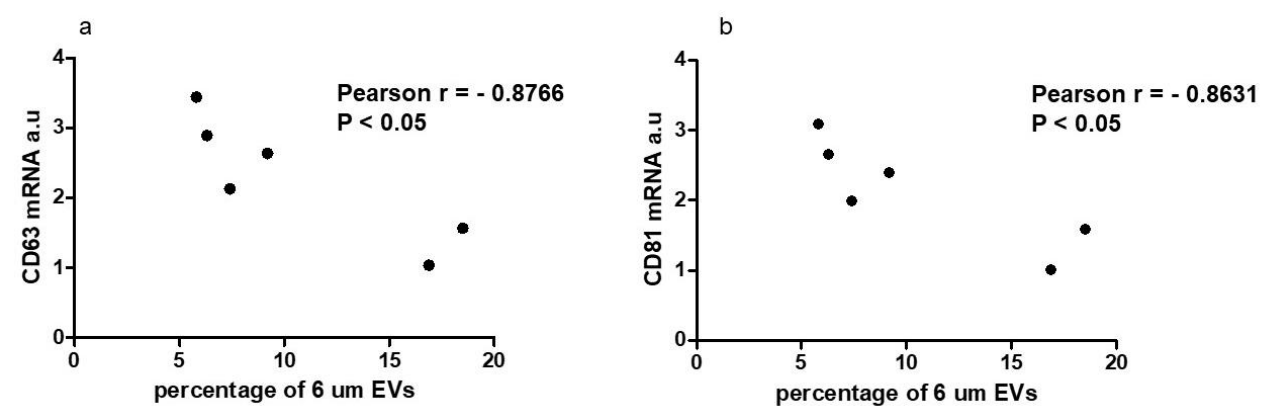
Figure 6. The number of cancer-derived 6 µ m EVs correlates with the expression of tetraspanins. The plots show the Pearson correlation between the expression levels of CD63 ( a ); and CD81 ( b ) in NTHY cells (after incubation with cancer-derived EVs) and the percentage of 6-µm extracellular vesicles (EVs) released by thyroid cancer cells.